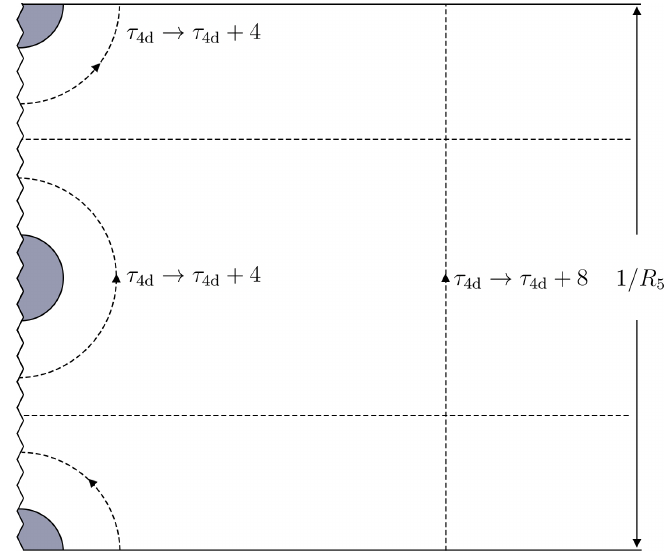
Figure 10 . Schematics of the F1 moduli space; again, the top and the bottom boundaries should be identified while the left end should be folded in half. The two shaded regions on the left end are both well approximated by a 4d pure Sp(1) theory but react a little differently to R